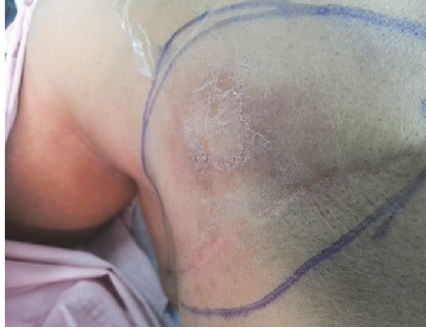
Figure1: Preoperativepictureoftheskinlesion ontherightanterior chest over the mastectomy scar.